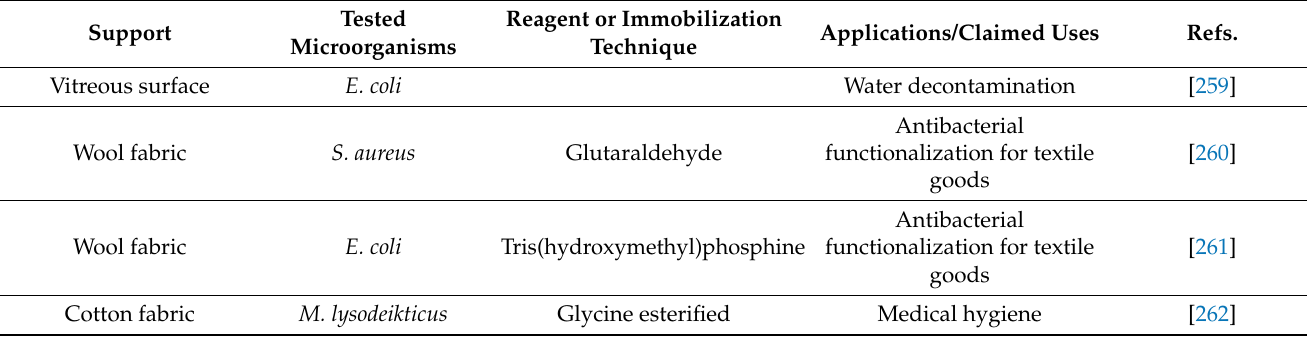
Table 5. Immobilization of